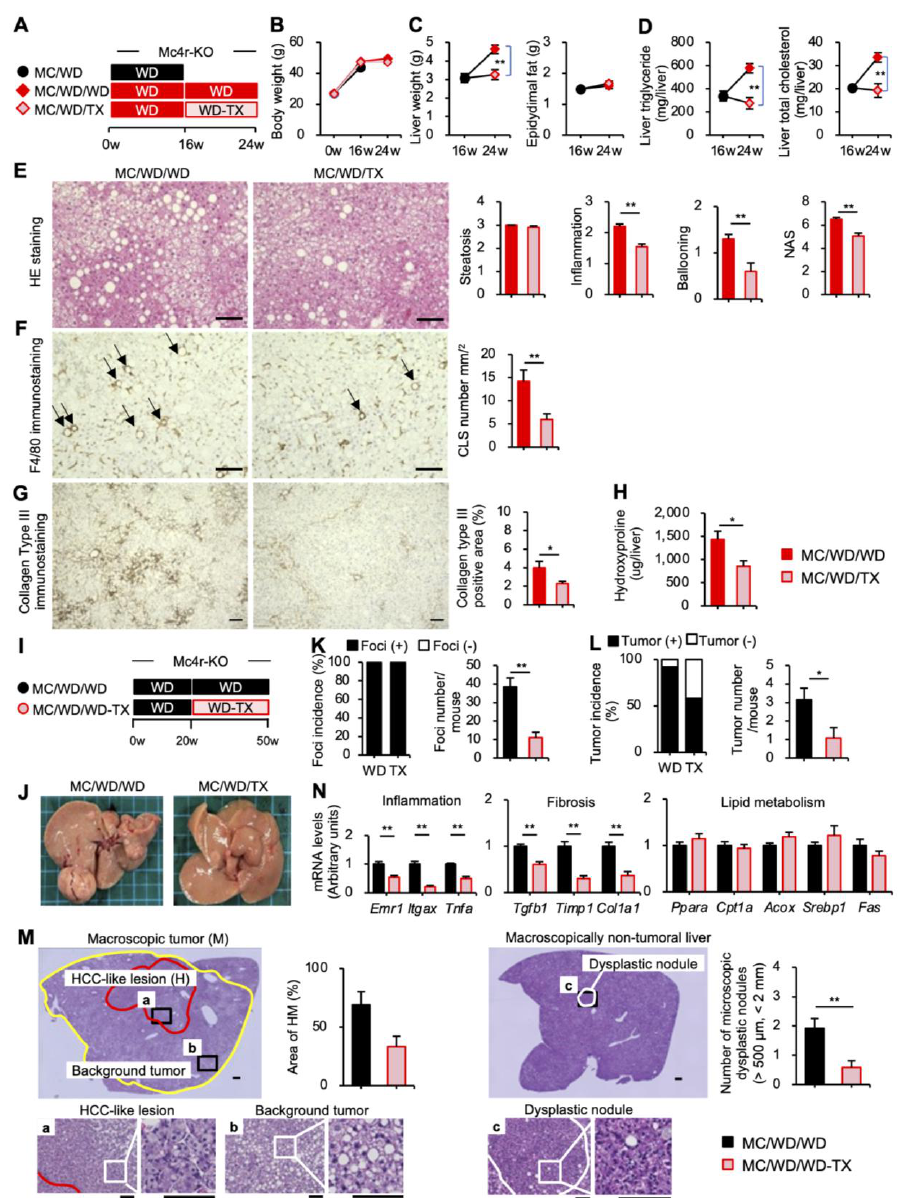
Figure 8. Therapeutic effects of Taxifolin on the progression of NASH in a mouse model. ( A ) Experimental protocol: the Mc4r -deficient mice were on a WD for 16 weeks to develop NASH and then treated with or without 3% Taxifolin for an additional 8 weeks (MC/WD/WD or MC/WD/TX, re- spectively). ( B ) Growth curve; ( C ) liver and epididymal fat weights; ( D ) hepatic triglyceride and total cholesterol contents. ( E – H ) Two groups: dark-red square, MC/WD/WD; light-red square, MC/WD/WD-TX. ( E ) HE staining of the liver. Histological analysis using the NAS. Scale bars: 100 µm. ( F ) F4/80 immunostaining of the liver. The arrows indicate the CLS. ( G ) Immunostaining for